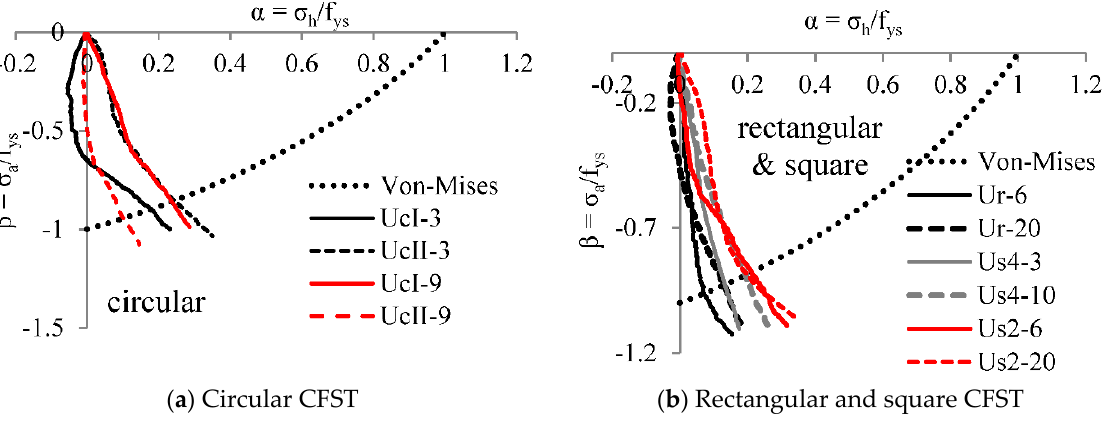
Figure 7. Development of biaxial stresses in UHSC CFST columns. Development of biaxial stresses in UHSC CFST columns are compared in Figure 7a,b). The transverse stress factor and axial stress factor, α and β in Equation (1), can be determined at the location where experimental stresses intersect the theoretical von-Mises failure criterion. Axial stress factor ( β ) is found to be greater than transverse stress factor ( α ), as axial stresses develop in early stages of loading while transverse stresses develop after concrete begins to dilate and induce transverse stresses in the steel tube [24]. Figure 8a,b shows typical experimental axial and transverse (hoop) strain develop- ment in UHSC CFST columns, illustrating significantly greater axial strain development while transverse strain often did not reach theoretical steel yield strain for columns with high slenderness. Experimental stress factors α and β are presented in Table 2 for UHSC- filled CFST columns. Table 2. Stress factors.